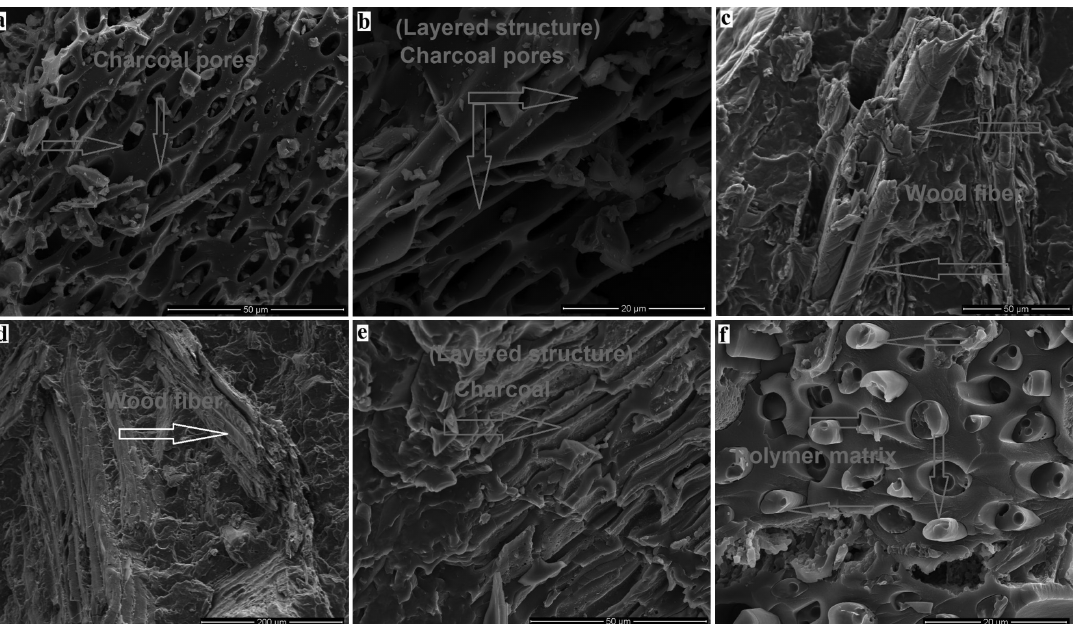
Figure 1. SEM images of charcoal flour and fracture surfaces of wood flour or charcoal flour filled polypropylene